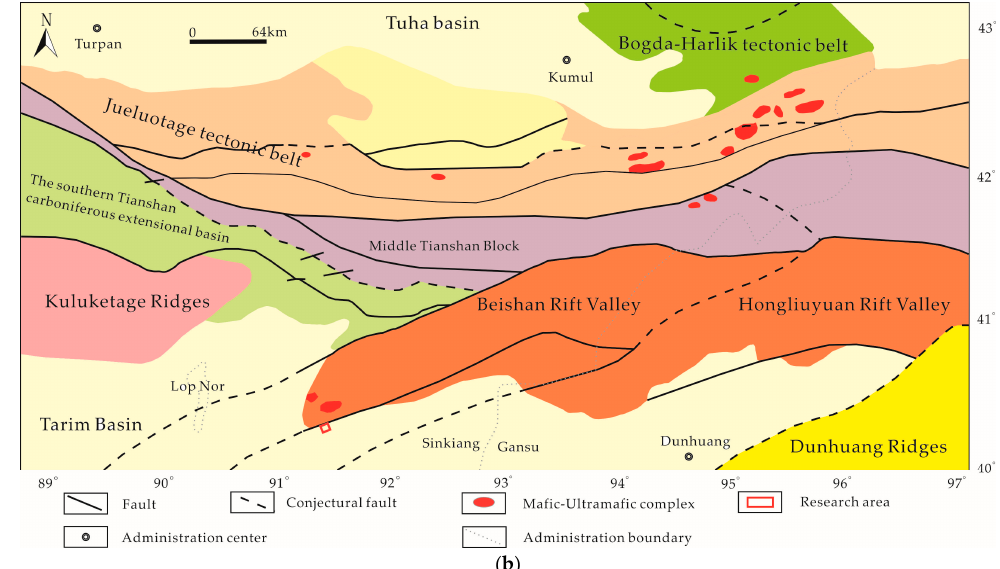
Figure 1. ( a ) Simplified tectonic map of China showing major cratonic blocks and orogenic belts, the location of study area is labeled (modified after Zheng et al. [38]). And a schematic geologic map of the study area is shown on the right (modified after a geological map at a scale of 1:100,000 which created in 2015 and Sun et al. [30]). Field survey points are shown in the schematic geologic map and field survey would be introduced in Section 3.1; and ( b ) regional tectonic map (modified after Su et al. [39]).